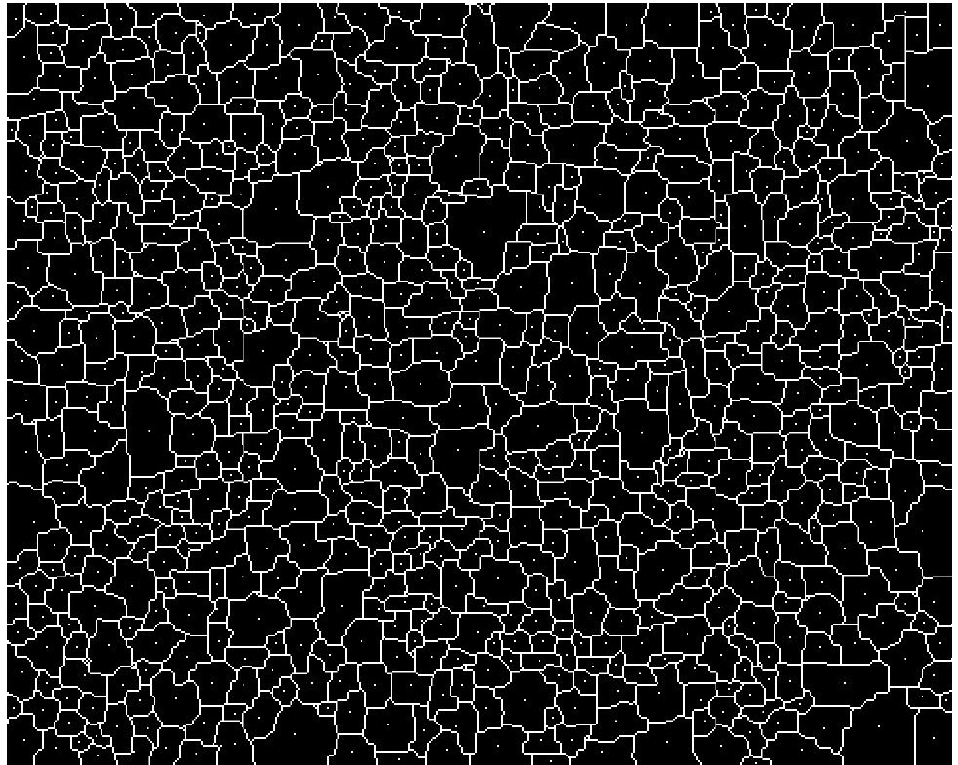
Figure 2. The multiresolution segmentation result and the centroids within each image object. (3) Find the Centroid of Each